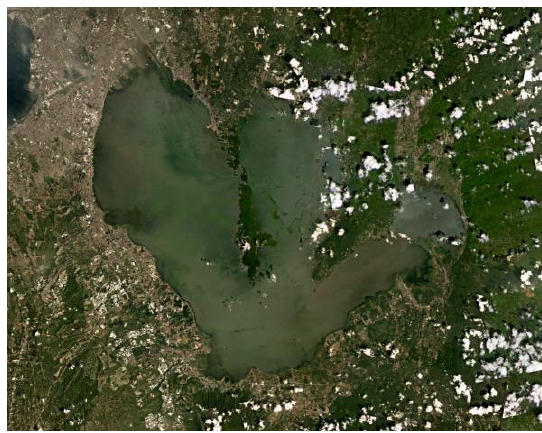
Figure 1 . Satellite image of Laguna Lake and the surrounding area from Planet Explorer taken in the month of October 2019.